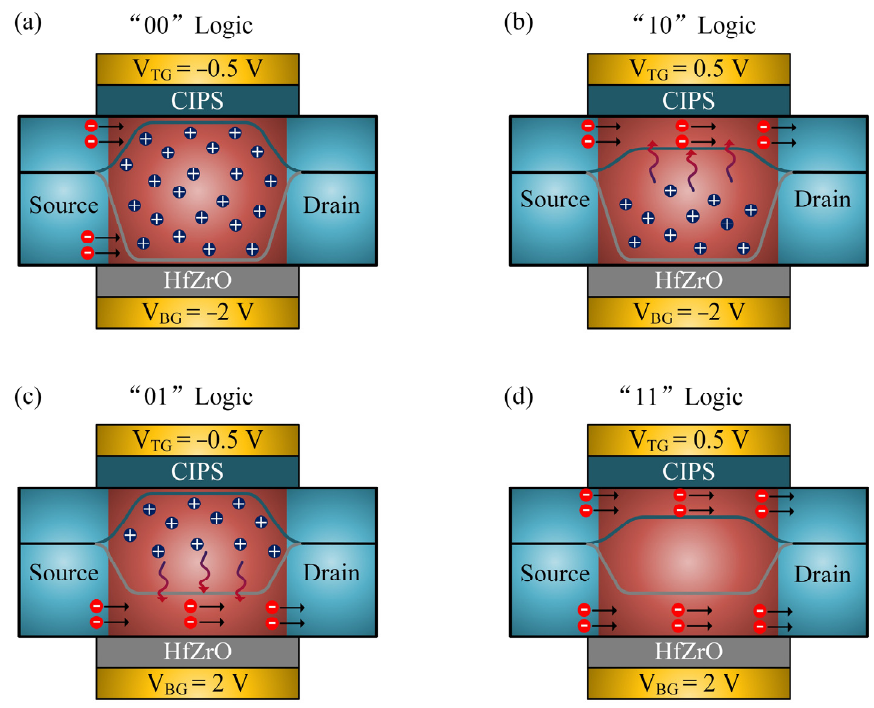
Figure 5. Schematic illustrations of the OR-Logic operation mechanism of the CIPS/MoS 2 vdW in-situ OR-Logic transistor. ( a ) “00” logic operation. ( b ) “10” logic operation. ( c ) “01” logic operation. ( d ) “11” logic operation.